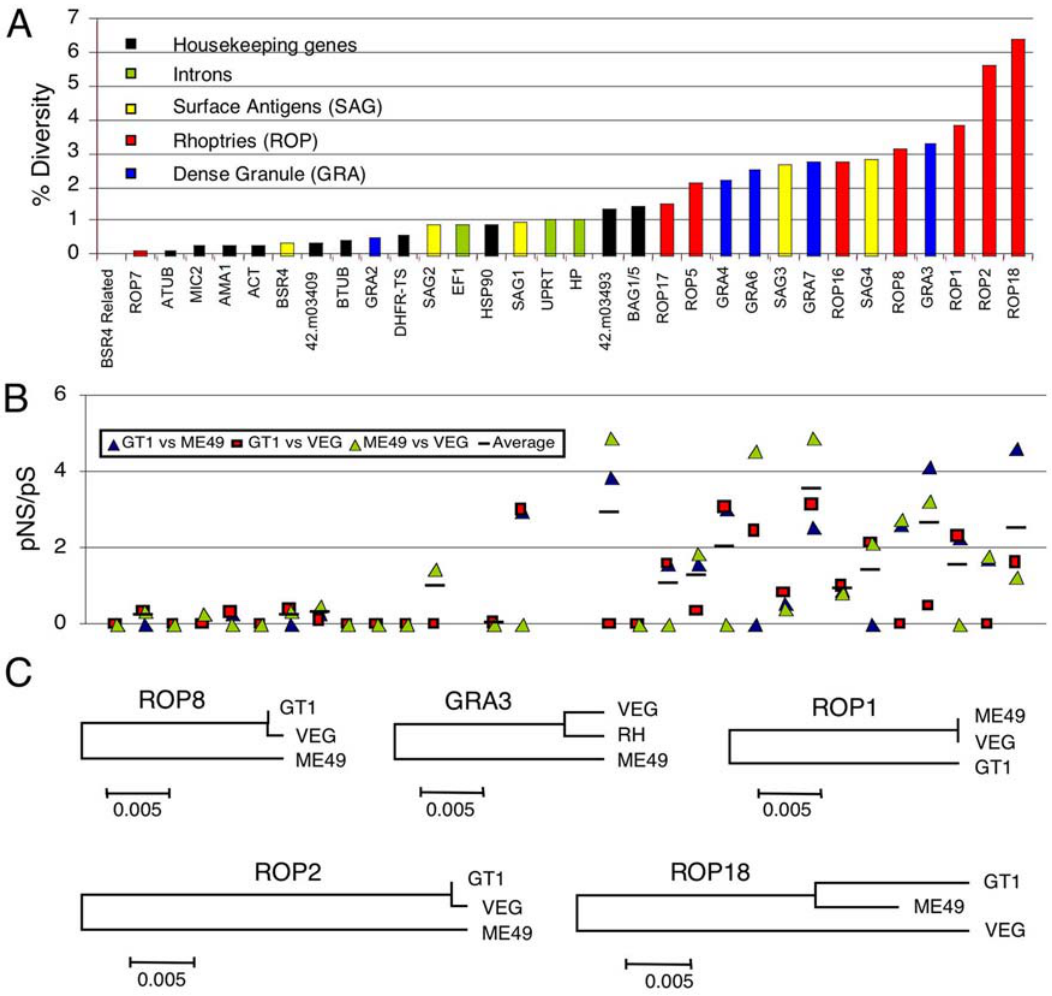
Figure 1. Diversity among T.gondii genes varies by category of coding function. A) Sequence diversity of genes and intronic sequences between representatives of type I (GT1), type II (ME49) and type III (VEG) strains of T. gondii . Loci listed at the bottom in rank order, annotations in Table S1. B) Ratio of pNS/pS as an indication of positive selection. Pairwise comparisons of sequences between strains as indicated. C) Neighbor joining trees reconstructed from variation in the five most divergent genes. Scale=substitutions per site.